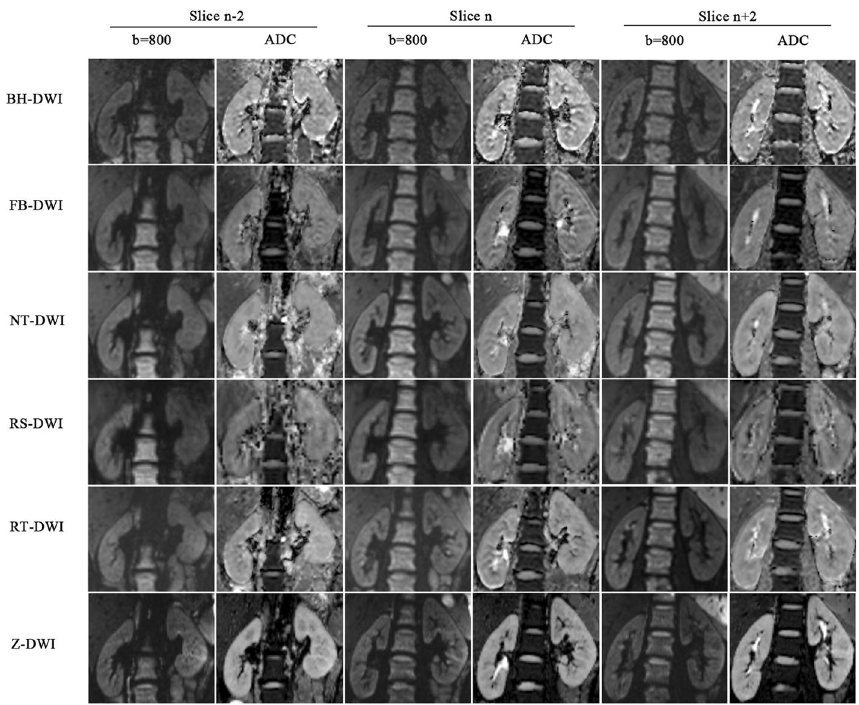
Figure 4. Comparisons of image quality of BH-DWI, FB-DWI, NT-DWI, RT-DWI, RS-DWI and Z-DWI at b = 800 s/mm 2 and corresponding ADC map. The image quality of Z-DWI was significantly different from BH-DWI, FB-DWI and RS-DWI in the three representative section (n-2 slice, n slice and n + 2 slice) in clarity of the renal cortex and medulla (ADC map) (all P < 0.05). Z- DWI was slightly superior to RT- DWI and NT-DWI in the three representative section (n-2 slice, n slice and n + 2 slice) in sharpness of boundaries (ADC map); however, the difference in image quality between the three was also not significant (all P >